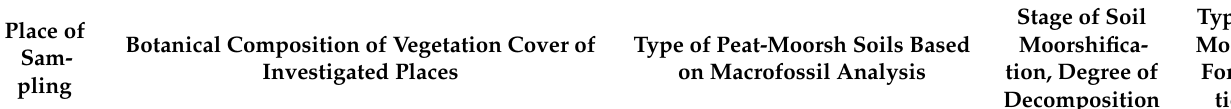
Type of Peat-Moorsh Soils Based on Macrofossil Analysis